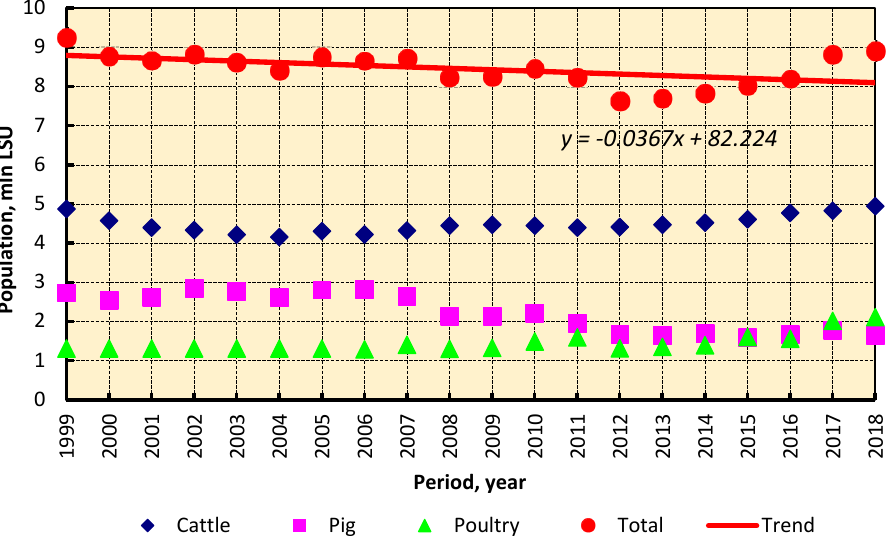
Figure 3. Animal population history.